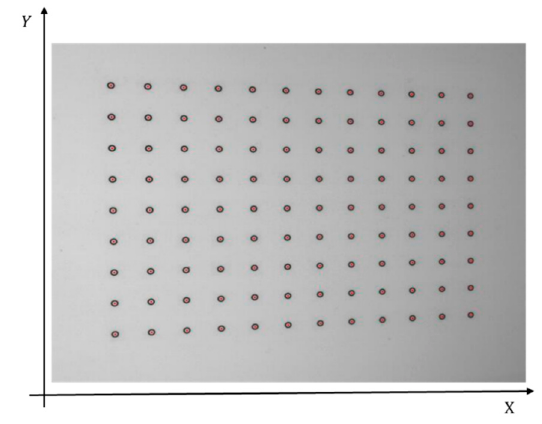
Figure 9. The extracted centre of the calibration rings. Table 1. Details of the accuracy and precision along transverse direction.